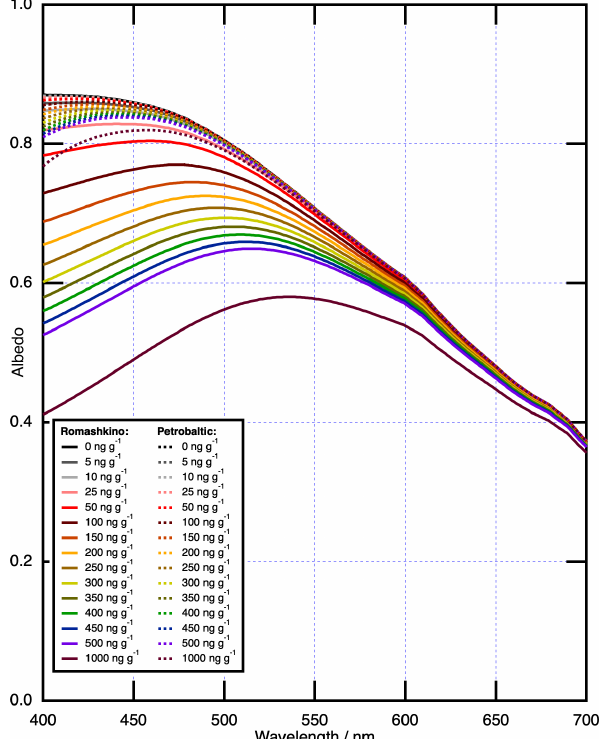
Figure 1. Wavelength-dependent albedo of first-year sea ice at in- creasing mass ratios of Romashkino (solid) and Petrobaltic (dotted) oils (0–1000ngg − 1 ) with a median droplet radius of 0.05µm. The first-year sea ice is quasi-infinite (15m thick), and the properties are described in Table 1. These data demonstrate sea ice albedo is sig- nificantly more responsive to Romashkino oil than Petrobaltic